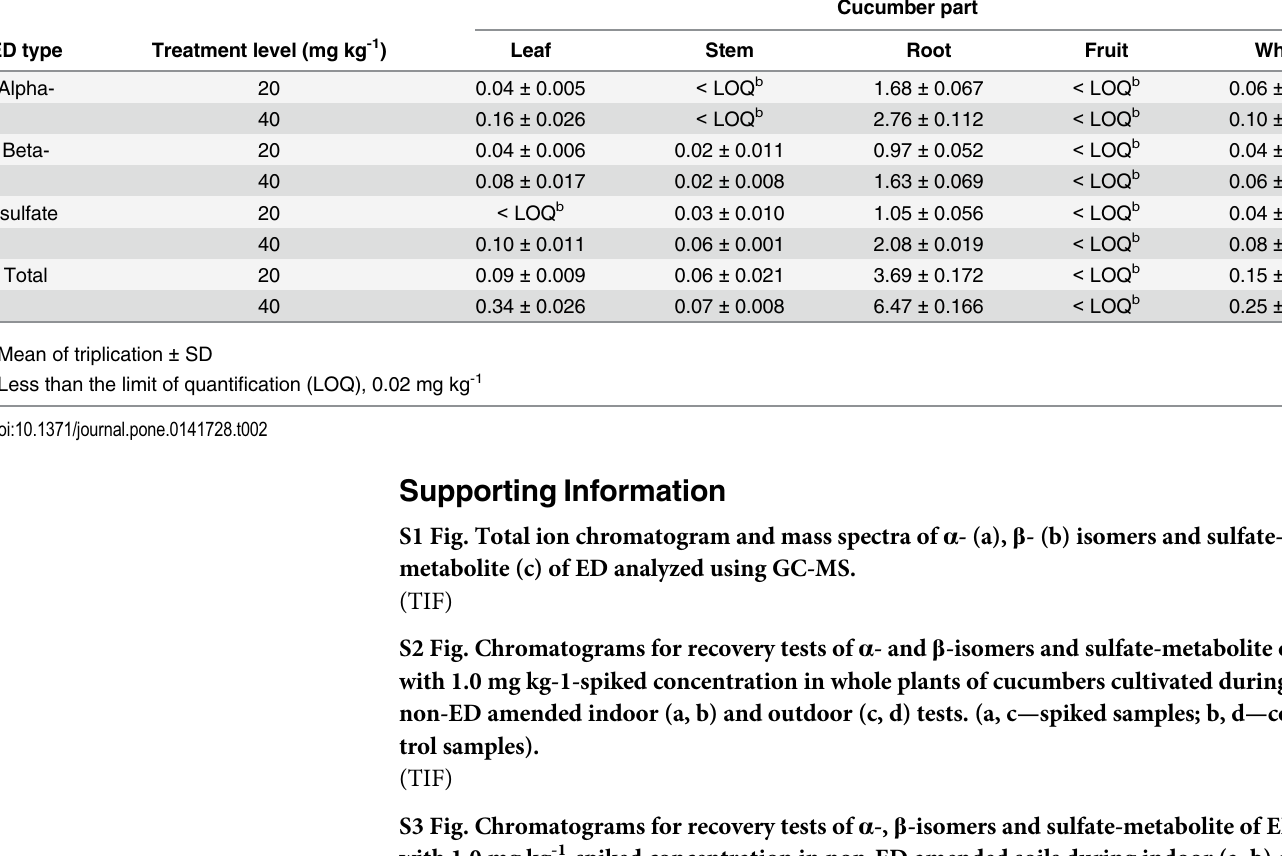
Table 2. Residue amounts of the isomers and sulfate-metabolite of ED in various compartments of cucumber plants grown for 120 d under green- house